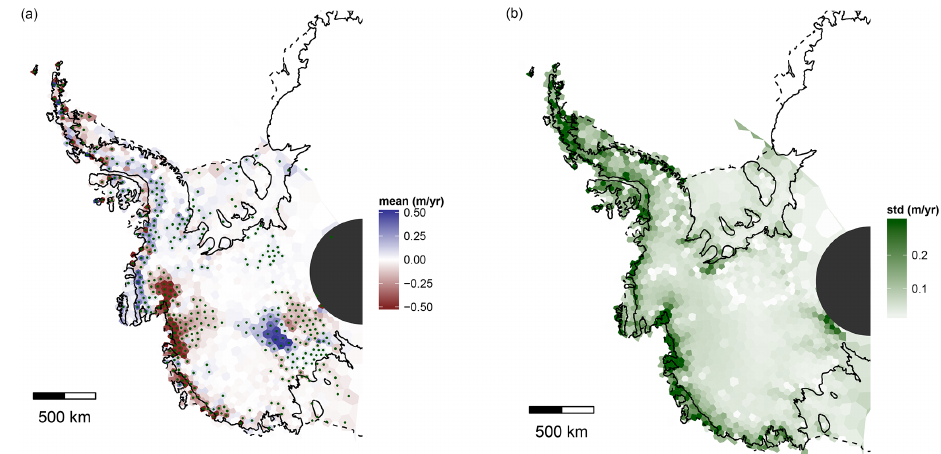
Figure 3. (a) Ice dynamics for 2003–2009 in myr − 1 . Stippled points denote areas in which the mean signal is larger than the marginal standard deviation. (b) Marginal standard deviation of ice dynamics for 2003–2009 in myr − 1